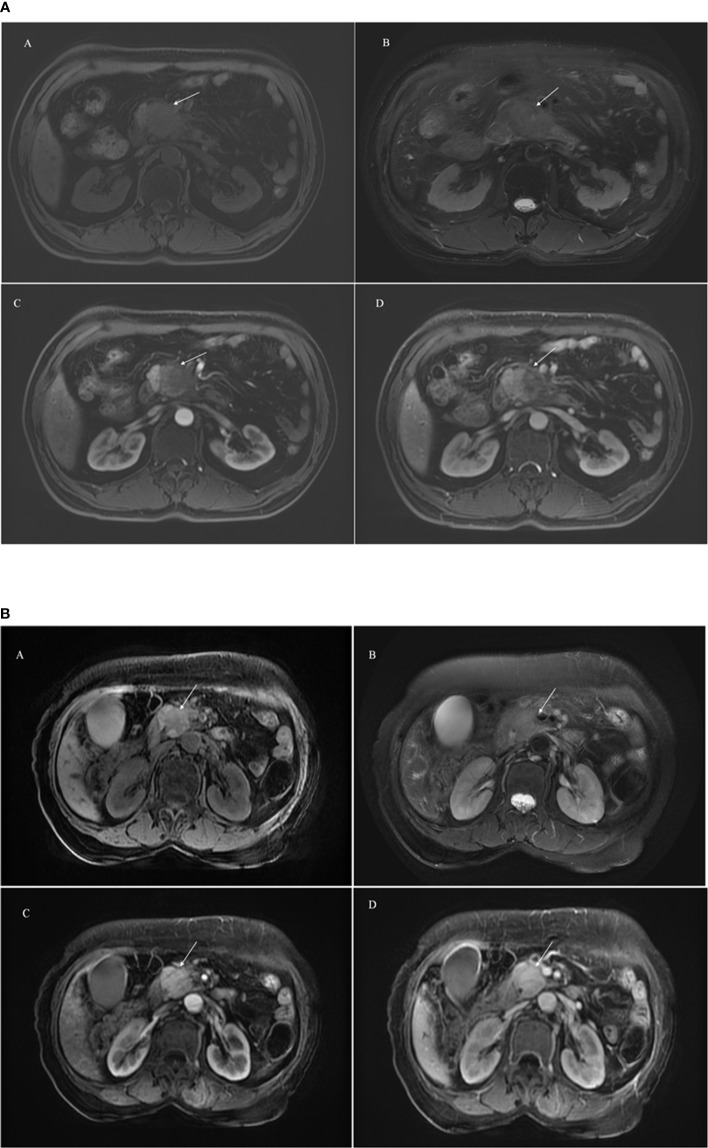
A 65-year male patient with PDAC showing an ill-defined mass (arrowhead) in the head of pancreas (2a). A hypointensity mass shows on axial T1WI (A), hyperintensity on axial T2WI (B), and unobvious enhancement during the artery (C) and portal venous (D) phase. A 58-year male patient with MFCP showing an mass (arrowhead) in the head of pancreas (2b). A hypointensity mass shows on axial T1WI (A), hyperintensity on axial T2WI (B), and gradual enhancement during the artery (C) and portal venous (D) phase.